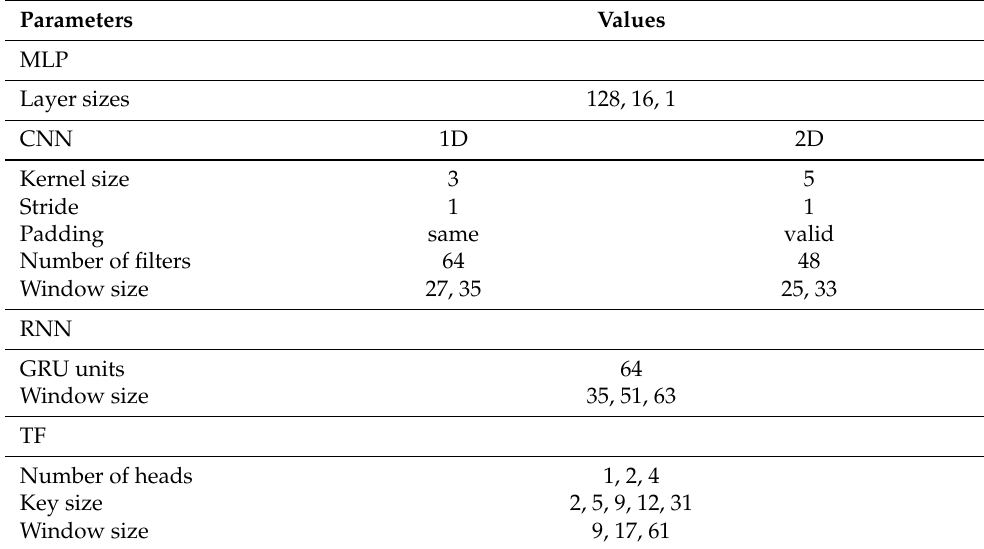
Table 4. Parameter and hyper-parameters used for testing the